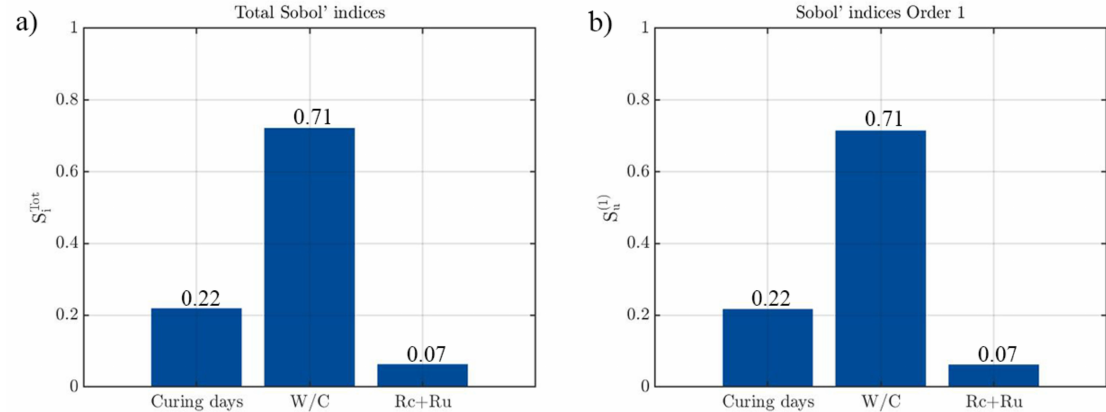
Figure 12. Results obtained during the sensitivity analysis of the strength model: ( a ) Total Sobol’indices and; ( b ) First-order